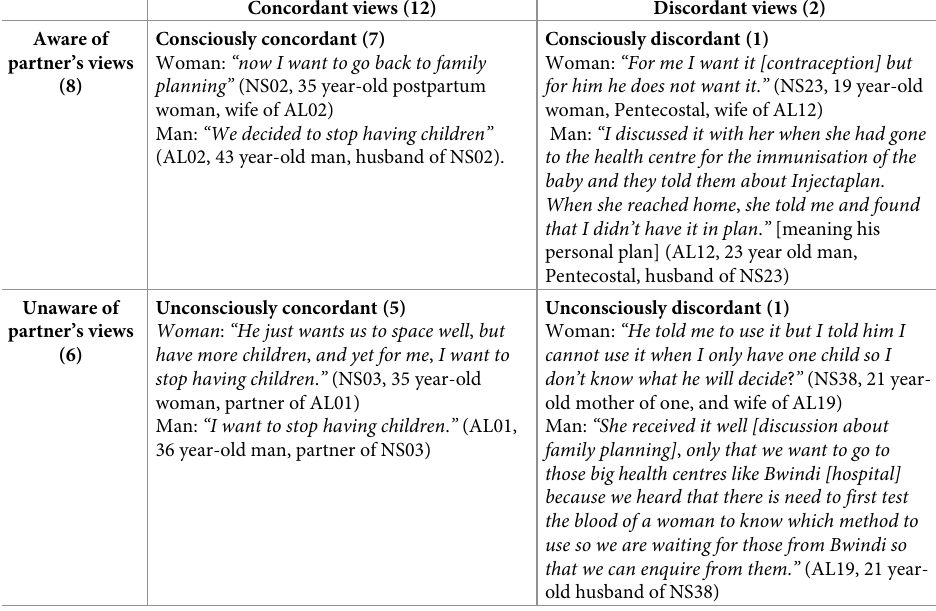
Table 3. Summary of levels of agreement between partners regarding family planning, and awareness of their partner’s views (numbers, and example quotes). Concordant views